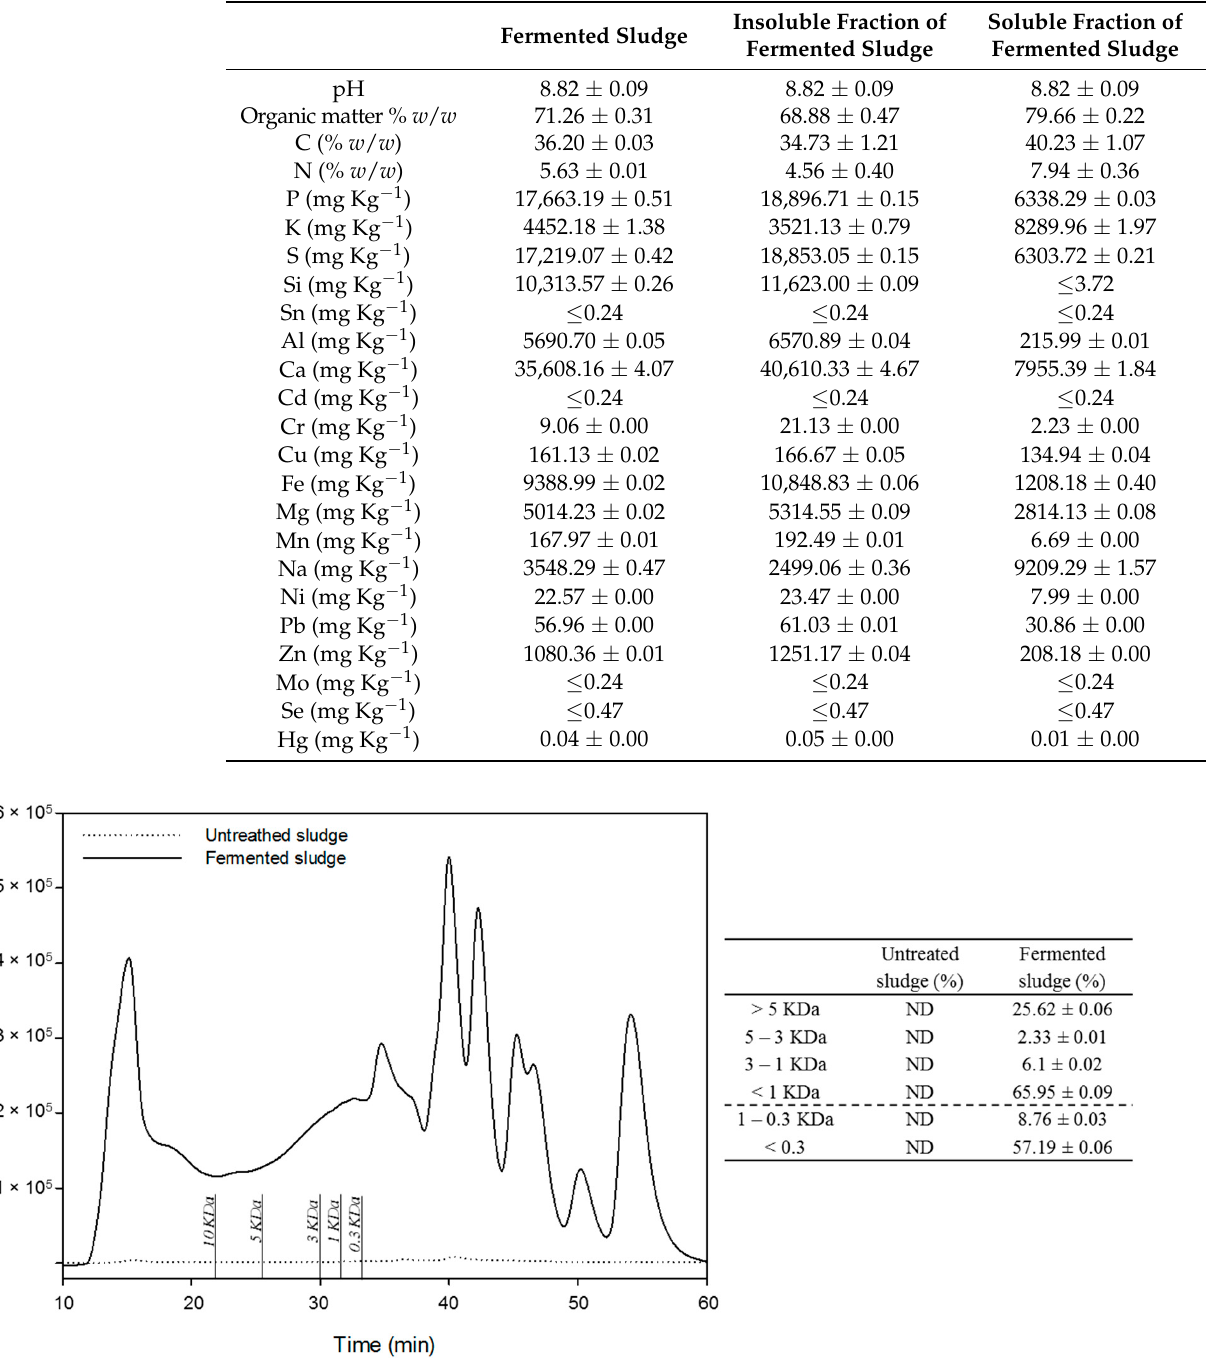
Table 1. The chemical characterization of the soluble organic component of the different fermented sludge-based biostimulants (media ± SD, n = 3).